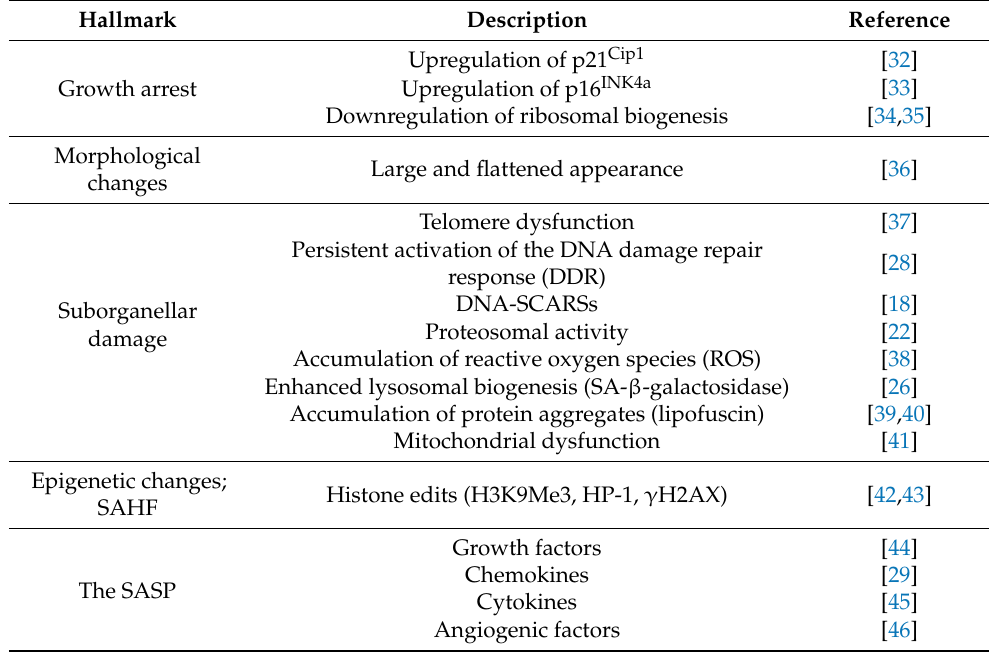
Table 1. Examples of the most frequently described hallmarks of cellular senescence.